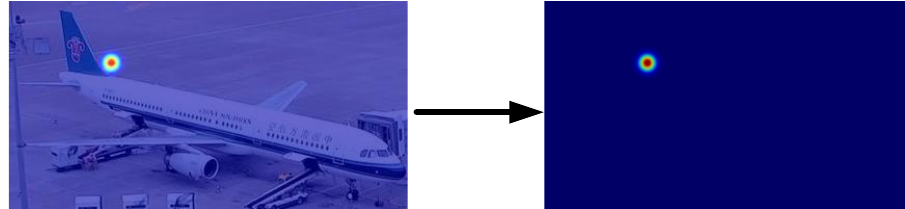
Figure 4. Heatmap of the aircraft’s left tail end